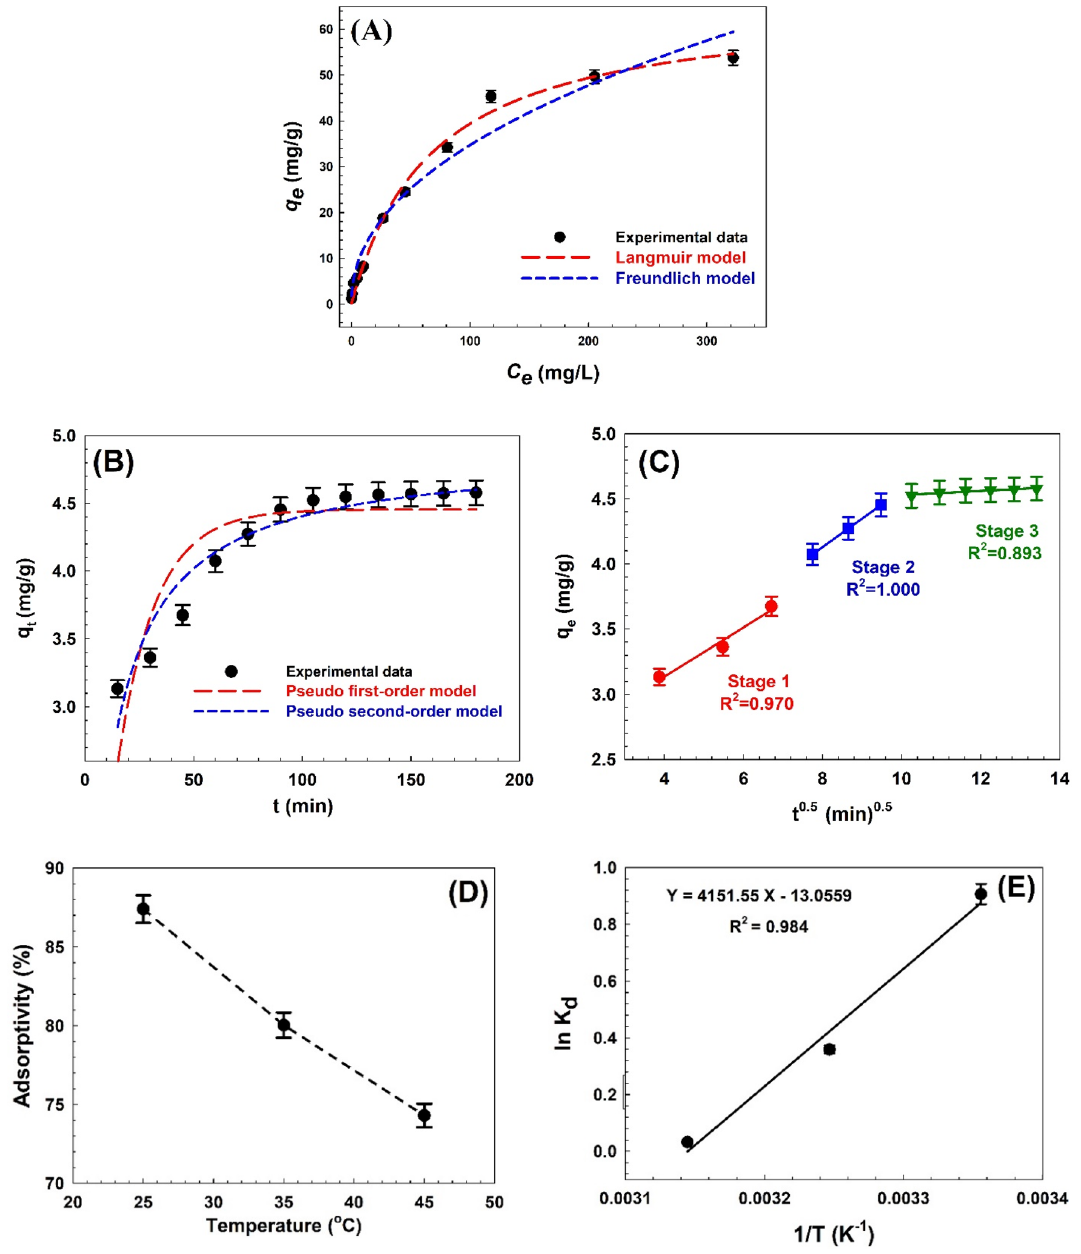
Figure 8. ( A ) Experimental isotherm models, ( B ) Experimental kinetic models, and ( C ) the diffusion model, ( D ) Effect of tempeture, and ( E ) adsorption thermodynamics of CV adsorption on